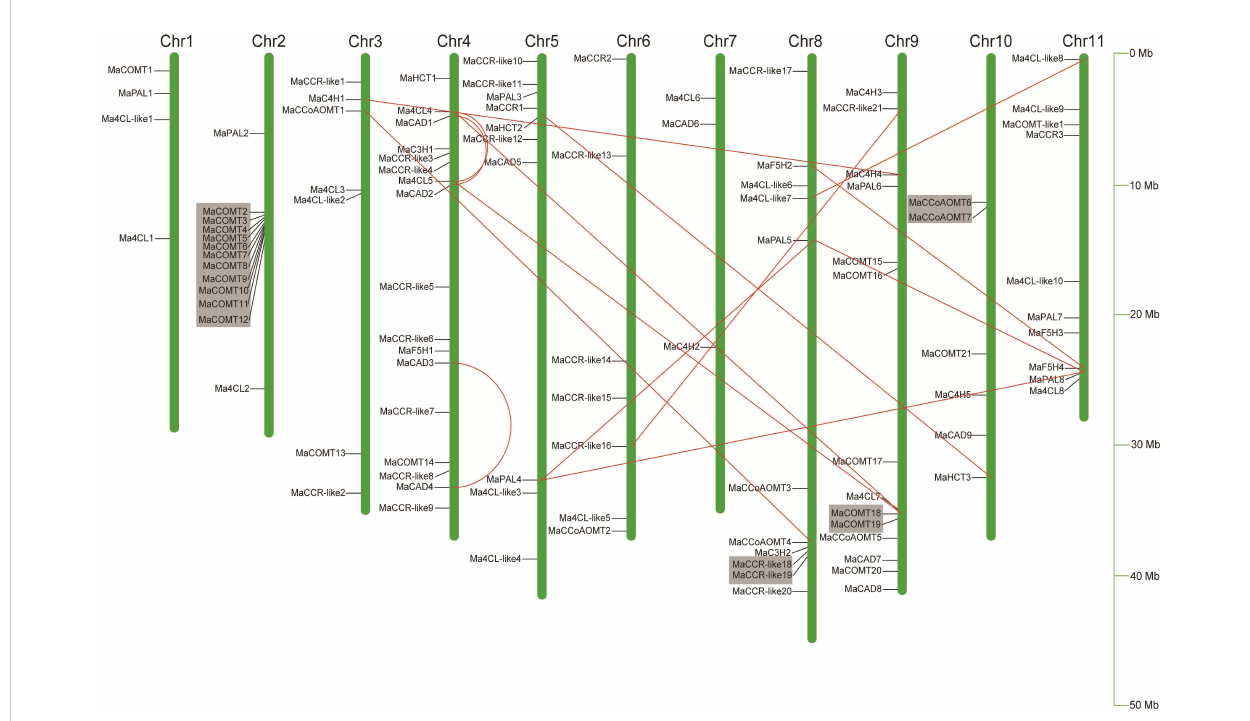
FIGURE 3 Localization of 102 lignin biosynthesis genes on eleven Musa acuminata genome chromosomes. The chromosomes were numbered between 1 to 11 and shown at the top of each chromosomes (Chr represented as bars). Chromosomal distances were given in Mb. Red line indicated segmental duplicated genes, and gray area indicated tandem duplicated